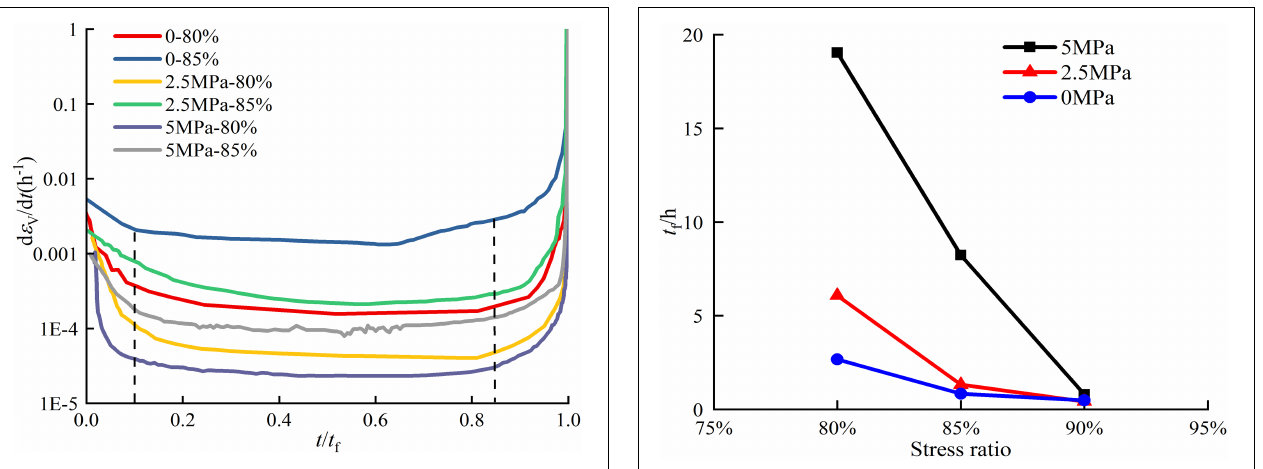
f at various stress level under each confining